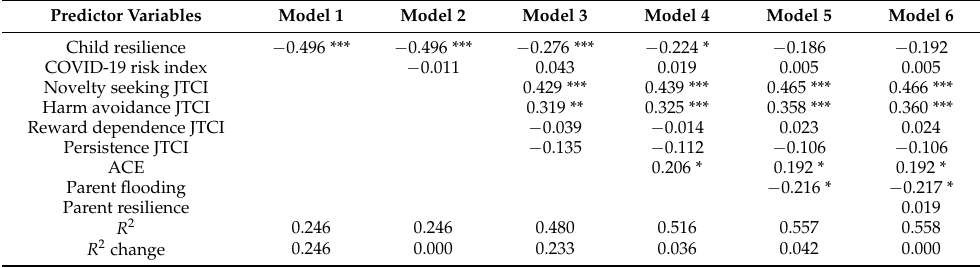
Table 5. Hierarchical regression analysis of predictors of total difficulties SDQ (girls